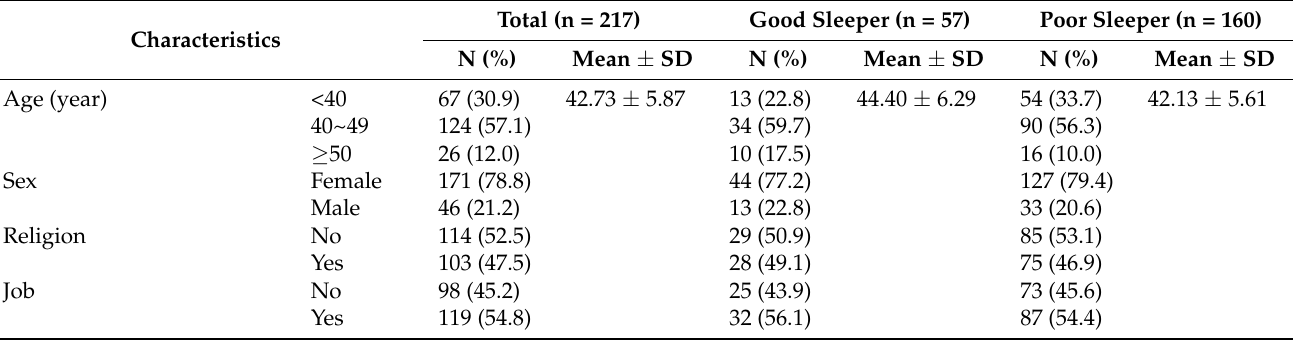
Table 1. Characteristics of the Participants (n =